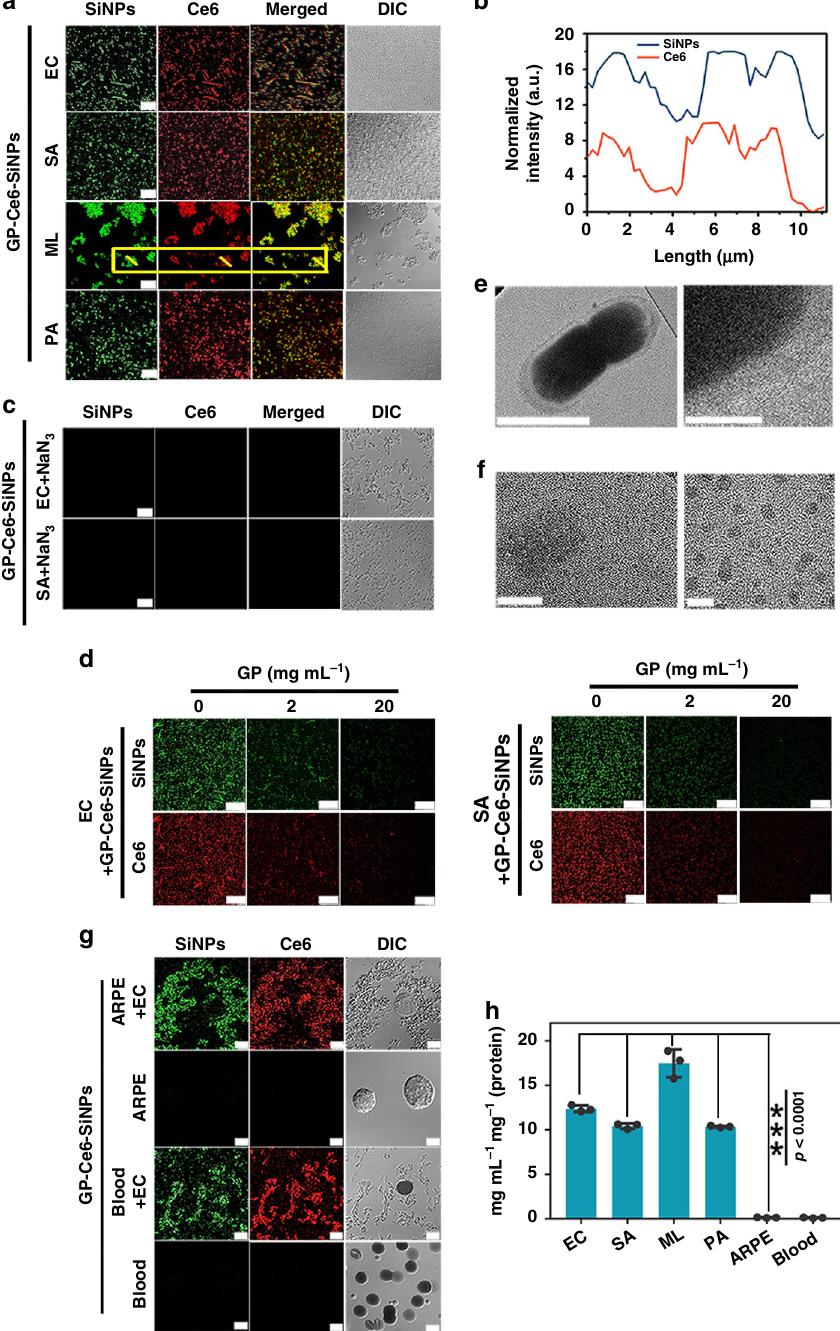
Fig. 3 In vitro imaging of Gram-negative and Gram-positive bacteria. a Confocal fl uorescence images of four different kinds of bacteria (EC, SA, ML, and PA) after incubation with GP-Ce6-SiNPs. Scale bar: 10 μ m. b Intensity pro fi les of ROI across the line shown in ML in panel ( a ) with confocal microscope. c Confocal fl uorescence images of EC and SA treated with NaN 3 and then incubated with GP-Ce6-SiNPs for 2 h. Scale bar: 10 μ m. d Confocal fl uorescence images of EC and SA incubated with GP with different concentrations (0, 2, 20 mg mL − 1 ) for 5 min and then incubated with GP-Ce6-SiNPs for 2 h. Scale bar: 25 μ m. e TEM (scale bar: 1 μ m) and zoom-in TEM (scale bar: 30 nm) images of intact EC and cell membrane of EC treated with GP-Ce6-SiNPs. f TEM (scale bar: 20 nm) and zoom-in TEM (scale bar: 5 nm) images of GP-Ce6-SiNPs nanoparticles in cell lysate of EC. g Confocal fl uorescence images of the mixture of ARPE cells and EC, pure ARPE cells, the mixture of human blood and EC, pure human blood after incubation with GP-Ce6-SiNPs. Scale bar: 25 μ m. h Histogram quantifying the level of GP-Ce6-SiNPs transport. Statistical analysis was performed using a one-way ANOVA analysis. Error bars represent the standard deviation obtained from three independent measurements (*** p < 0.001, n = 3). In the above experiments, the fi nal concentration